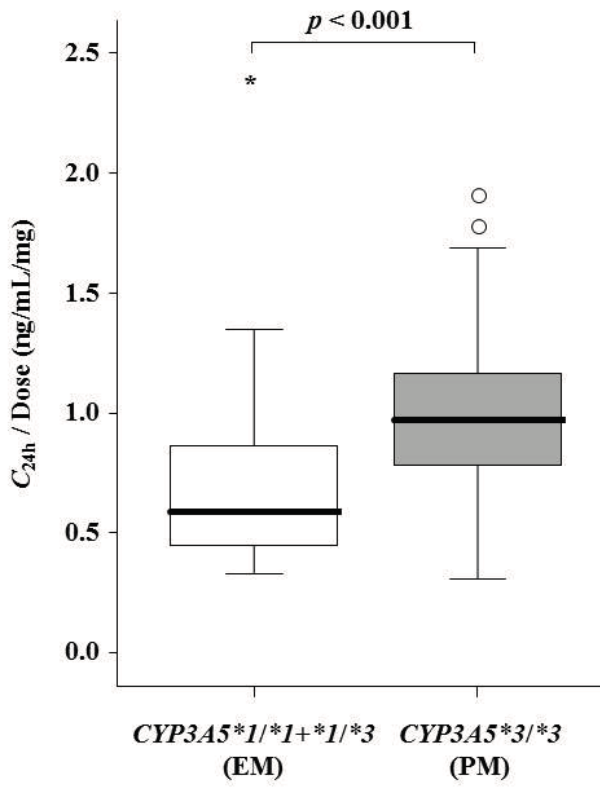
Figure 1. Comparison of dose-adjusted trough concentrations ( C 24h /dose) just prior to the second dose of tacrolimus pre-transplantation between CYP3A5 extensive metabolizer (EM) (white boxes) and poor metabolizer (PM) (gray boxes) patients. Graphical analysis was performed using an SPSS box and whiskers plot. The box spans data between two quartiles (IQR), with the median represented as a bold horizontal line. The ends of the whiskers (vertical lines) represent the smallest and largest values that were not outliers. Outliers (circles) are values between 1.5 and 3 IQRs from the end of the box. Values of more than three IQRs from the end of the box are defined as extreme